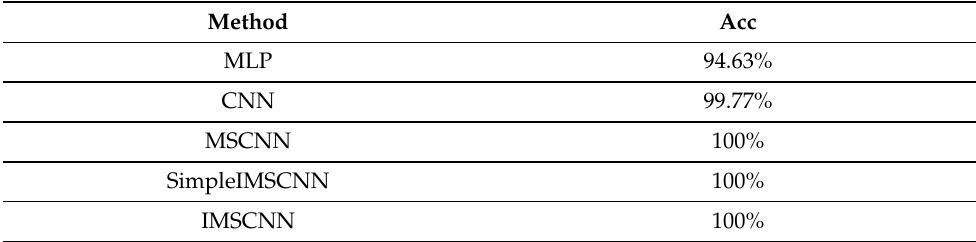
Figure 6. Feature visualization via t-SNE: CWRU dataset. ( a ) MLP; ( b ) CNN; ( c ) SimpleIMSCNN; ( d ); MSCNN ( e ) IMSCNN ( f ) class of the each color. Table 6. The accuracy of each method in CWRU